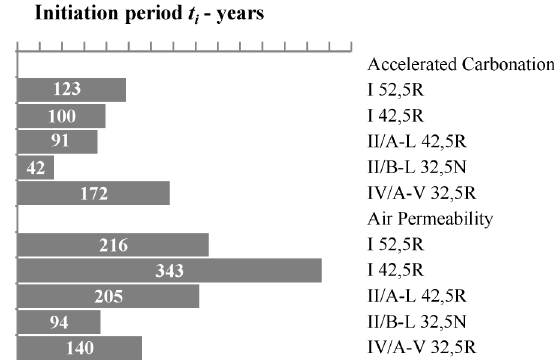
Fig. 4. Design lifetime for target period of 50 years, by accelerated carbonation and air permeability methods, for the exposure class XC3